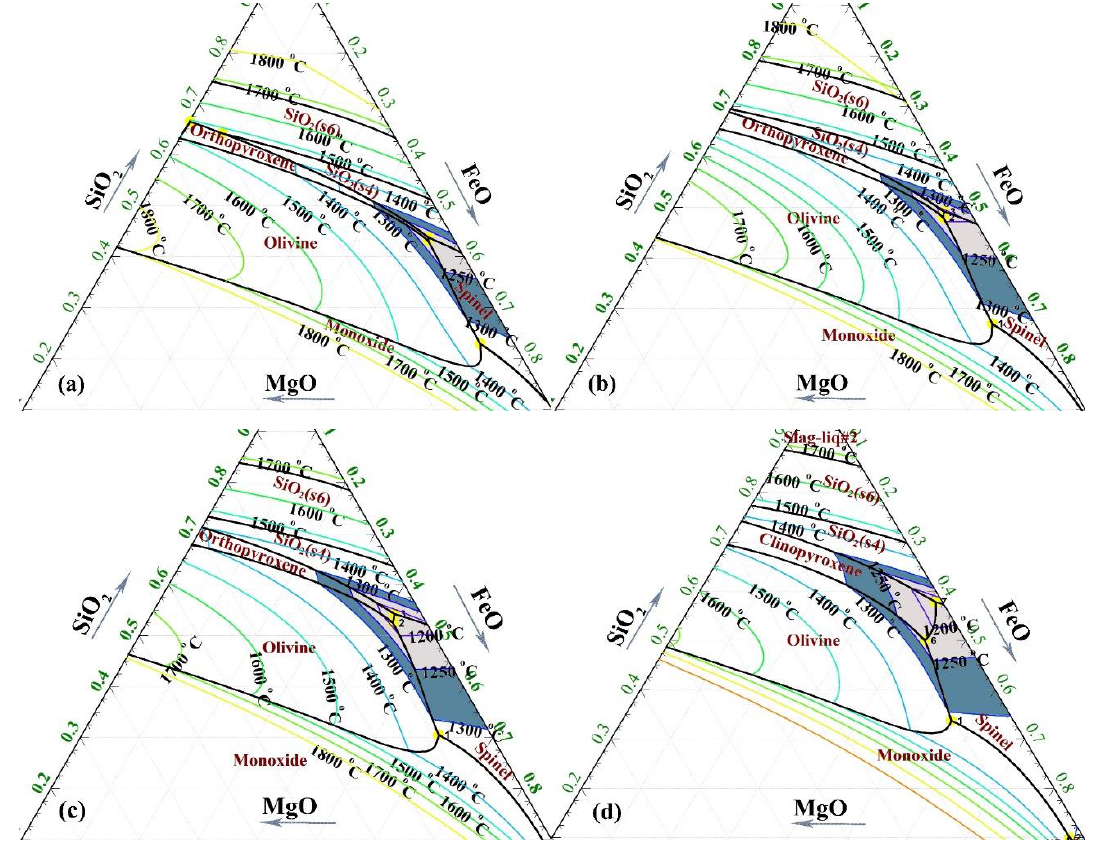
Figure 1. Phase diagram of Fe x O-SiO 2 -CaO-MgO-“NiO”system, at P O2 = 10 − 7 atm, 0.26 wt.% NiO ( a ) 5 wt.% CaO; ( b ) 9 wt.% CaO; ( c ) 13 wt.% CaO; ( d ) 17 wt.% CaO.